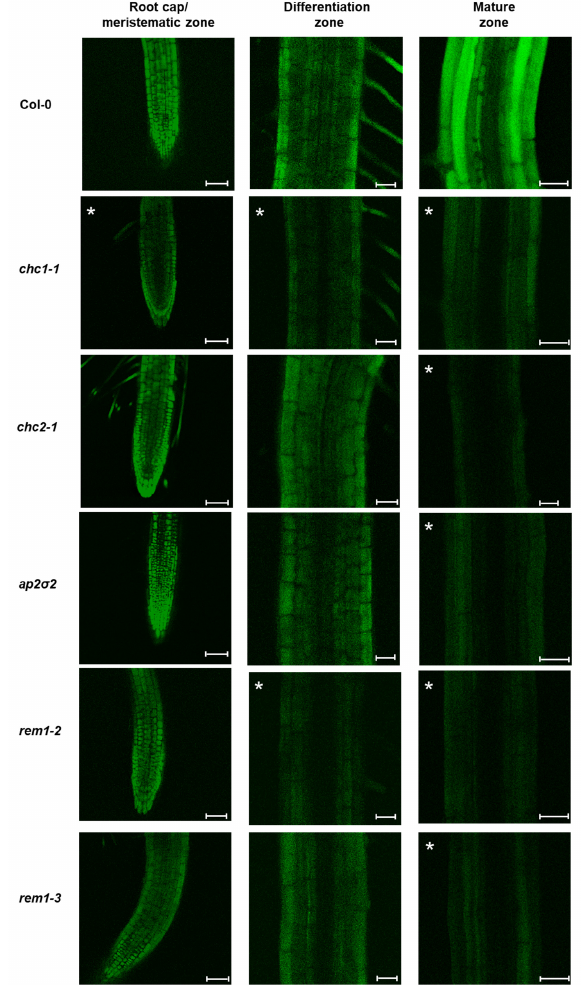
Figure 5. Internalization of miPEP165a is clathrin and remorin dependent. Representative confocal images showing the uptake of miPEP165-FAM 48 h after treatment in wild-type seedlings and chc1-1 , chc2-1 , ap2 σ 2 , rem1-2 , and rem1-3 mutants. A significant fluorescence decrease for each condition is indicated in each panel by asterisks. Quantifications of the fluorescence intensity from more than 15 seedlings are shown in Figure S3. Bar = 50 µ m (root cap / meristematic zone) or 25 µ m (di ff erentiation and mature